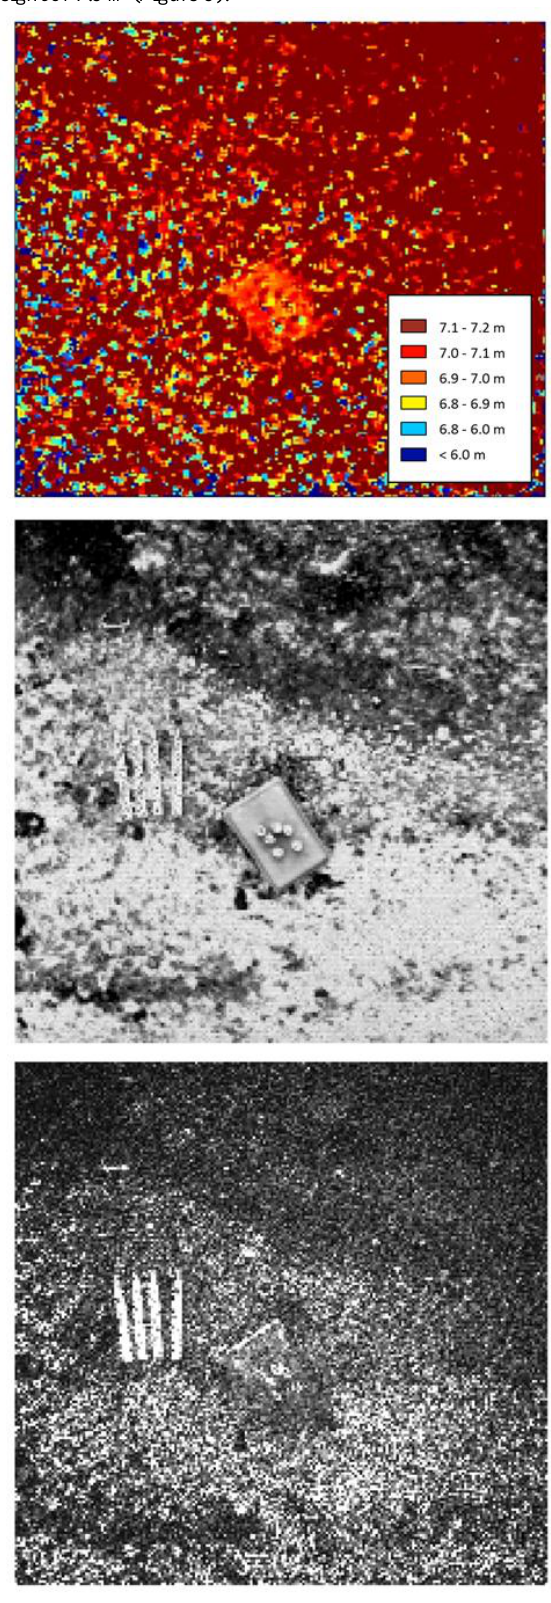
Figure 5: Aerial range image (7.5 m flight height) (Kohoutek et al. 2011) top: median filtered single distance image, middle: single intensity image, bottom: single amplitude